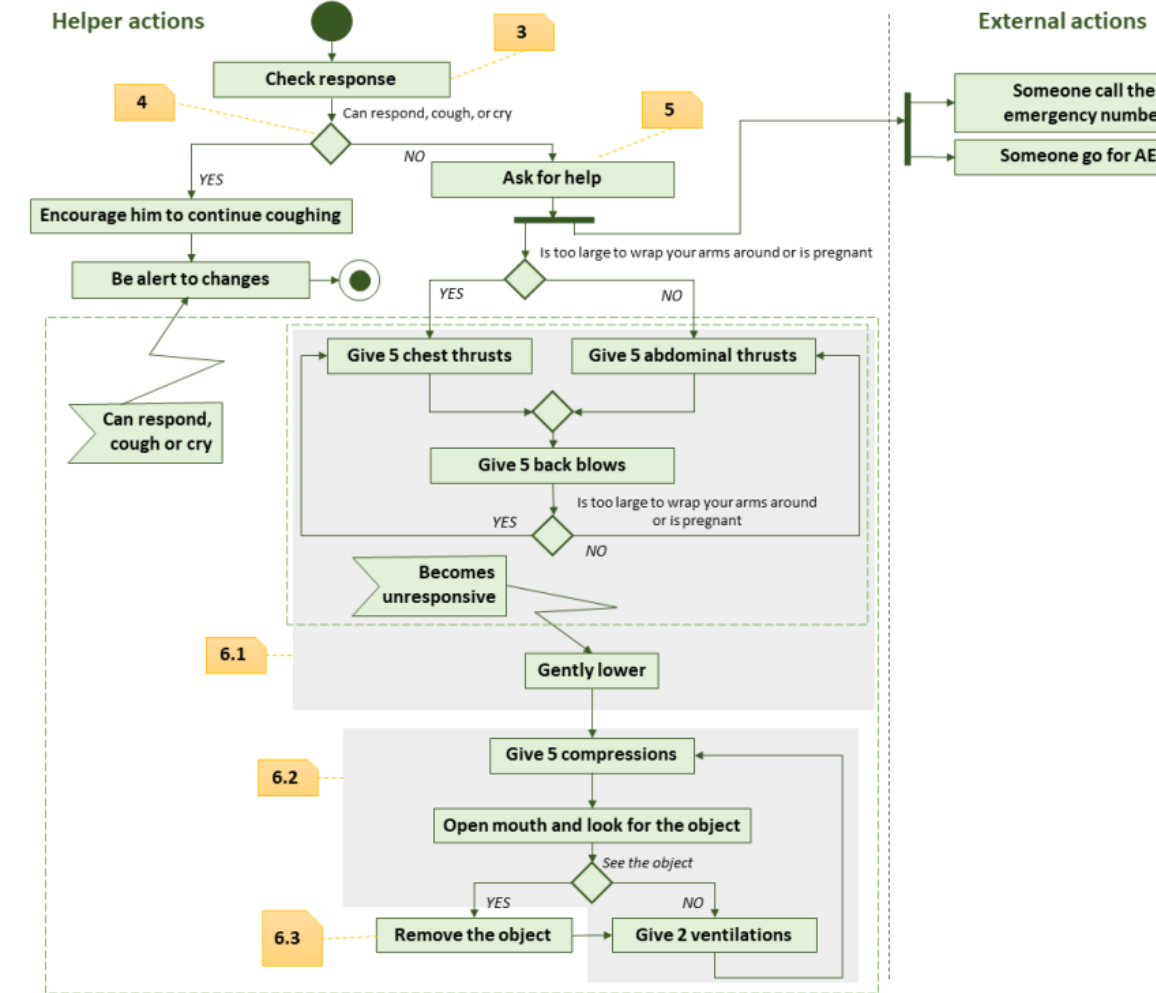
Figure 1. Main steps of the first-aid procedure that has to be applied in a choking emergency. The numbers in the boxes indicate the relationship of the minigames 3, 4, 5, and 6 with the procedure steps. AED: automated external